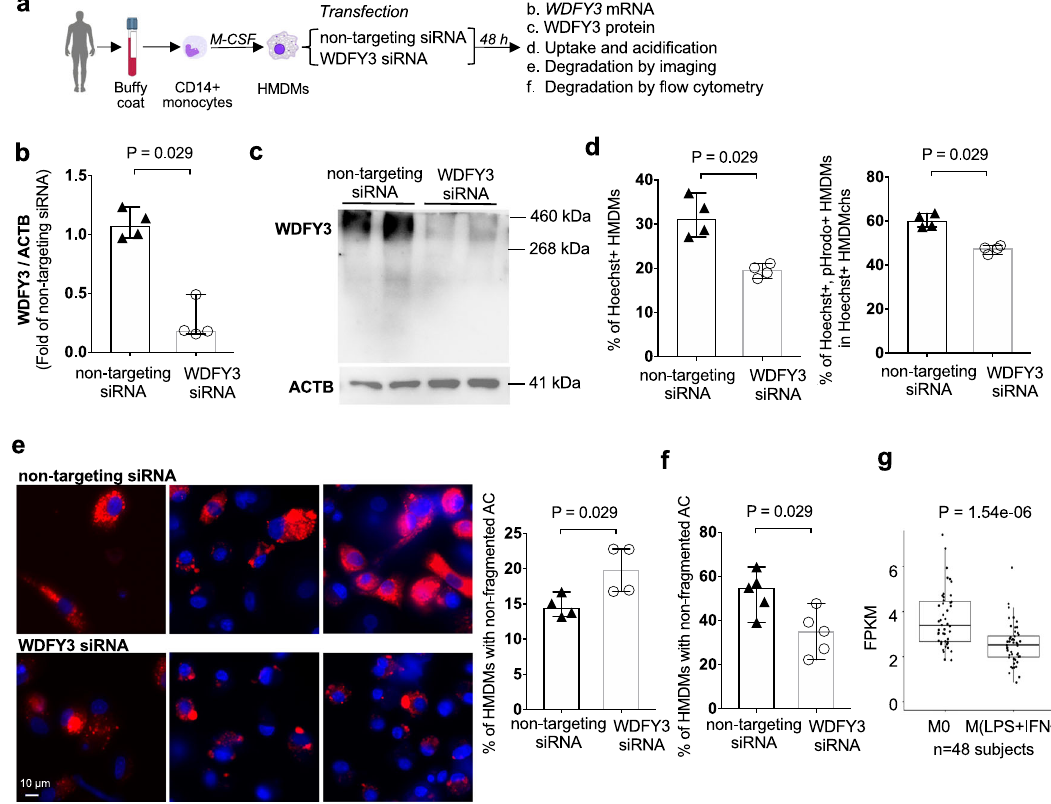
Fig. 6 | WDFY3 regulates efferocytosis in humanmacrophages.a Schematics of human monocyte differentiation to macrophages (HMDMs) and knockdown of WDFY3 with Lipofectamine RNAiMAX-mediated transfection of siRNAs targeting WDFY3 , or non-targeting siRNAs as the control. b Validation of knockdown ef fi - ciency at mRNA level by qRT-PCR ( n =4 independent experiments, each from the average of 3 technical replicates). c Validation of knockdown ef fi ciency at protein level by western blot ( n =2 biological replicates, data are representative of 3 independentexperiments). d EfferocytosisofapoptoticJurkatcellslabeledbyboth Hoechst and pHrodo. The percentage of HMDMs with Hoechst-labeled ACs (indi- cating uptake), and the percentage of Hoechst + /pHrodo + HMDMs in Hoechst + HMDMs (indicating acidi fi cation upon uptake) were quanti fi ed by fl ow cytometry. Both uptake and acidi fi cation of ACs were impaired in HMDMs with siRNA- mediated WDFY3 knockdown ( n =4 independent experiments, each from the